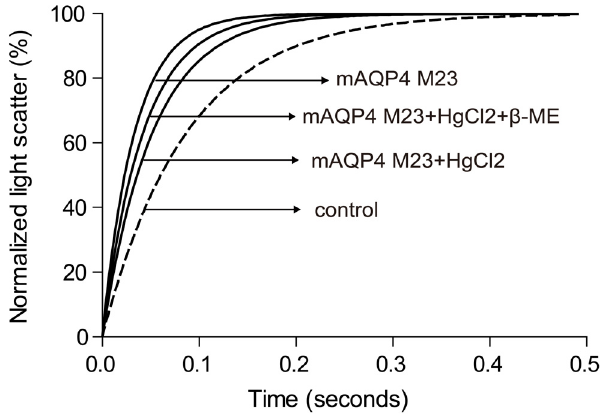
Figure 5. Specific inhibition of mAQP4 M23 water transport. Proteoliposomes containing D-CF produced mAQP4 M23 were treated with 300 m M HgCl 2 for 5 min. at 23 u C. For the recovery of the function of mAQP4 M23 function, 2 mM b -mercaptoethanol ( b -ME) was added and incubated 10 min. at 23 u C after incubation with HgCl 2 . Empty liposomes with and without treatment by HgCl2 were used as control and showed identical curves (dashed line).